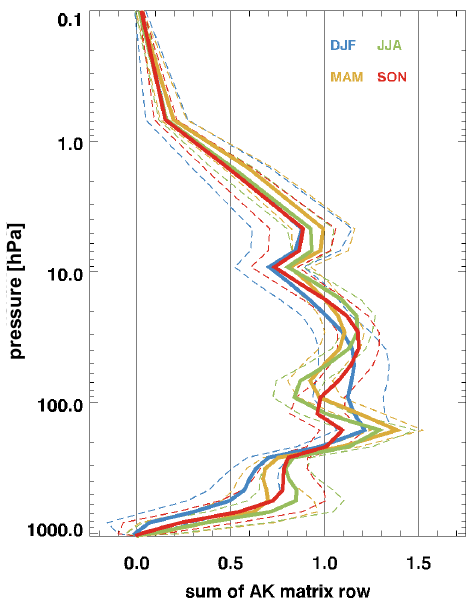
Figure 3. Mean sums of rows of the averaging kernels separated by season (southern hemispheric stations offset by 6 months). All IASI scenes as indicated in Table 1 are